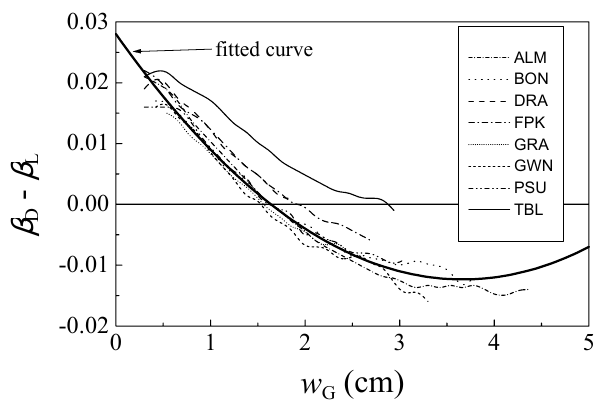
Fig. 4. Average differences between turbidity estimates by Dogni- uax’s correlation and Louche’s algorithm versus precipitable water by Gueymard’s approach for each location.